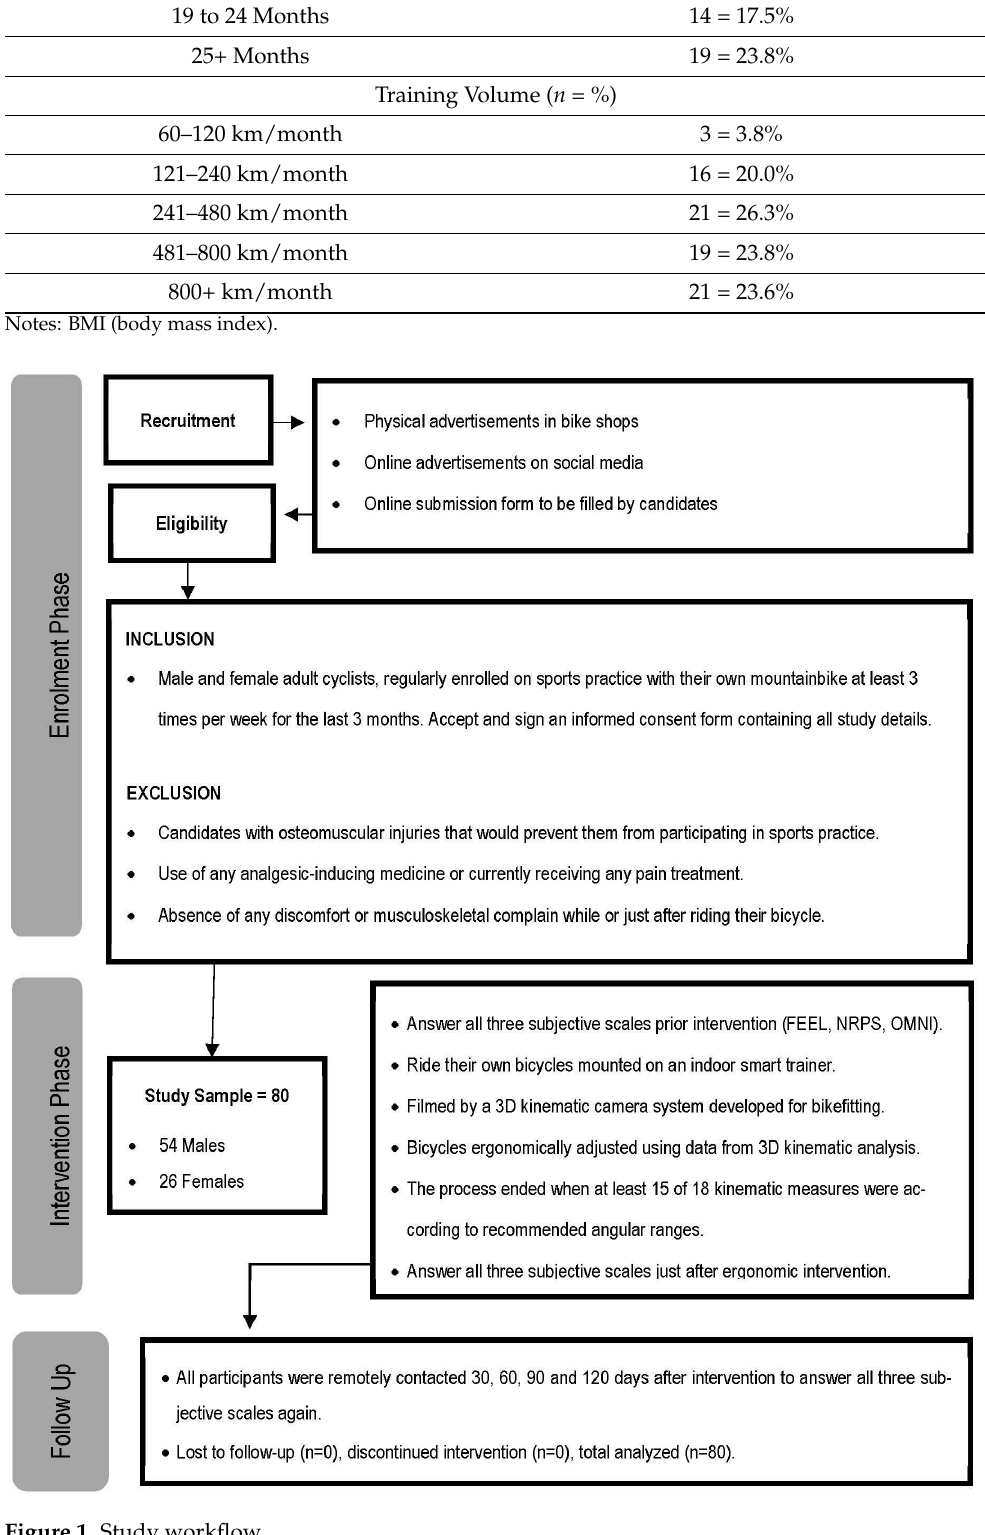
Figure 1. Study workflow.